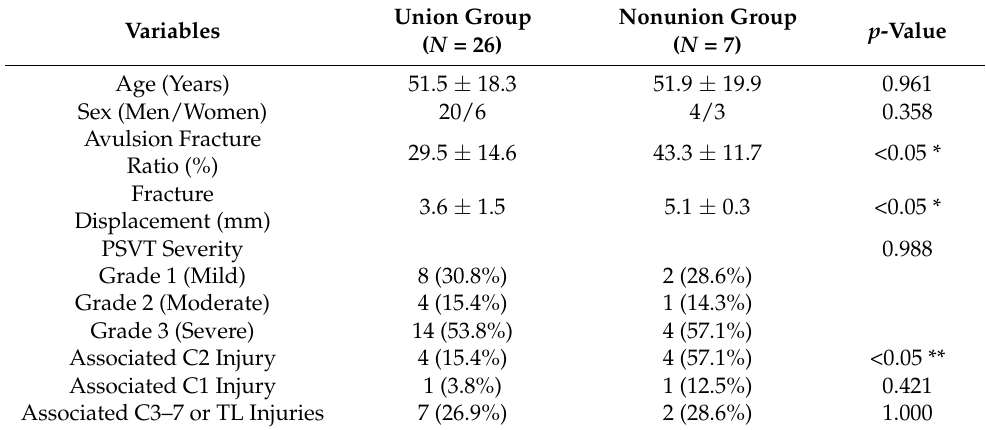
Table 1. Summary of conservatively managed anterior tear drop fractures of C2 (2nd cervical vertebra).